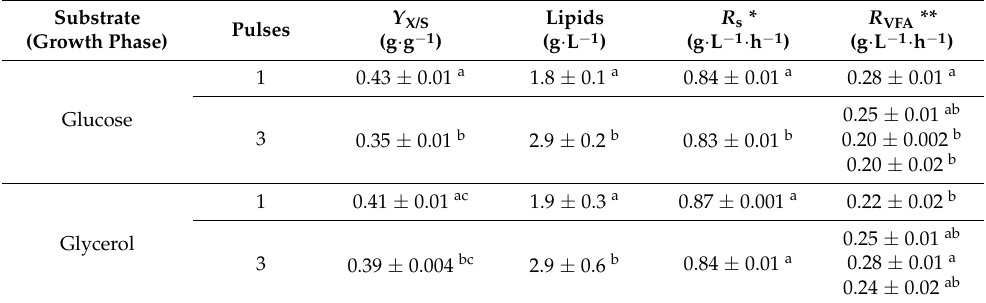
Table 1. Values of global biomass yield ( Y X/S ), maximum lipids concentration and substrate (glucose or glycerol) uptake rate, and VFAs ( R VFA ) obtained in Y. lipolytica W29 two-stage batch cultures.